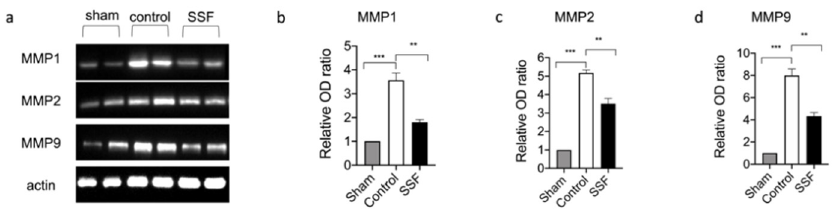
Figure 3. ( a ) Western blot analysis of wound tissue for matrix metalloproteinases MMP-1, MMP-2, and MMP-9, and relative densitometric analysis respectively. ( b – d ). Data are presented as means ± SEM images of 10 mice for each group. ** p < 0.01; *** p < 0.001.